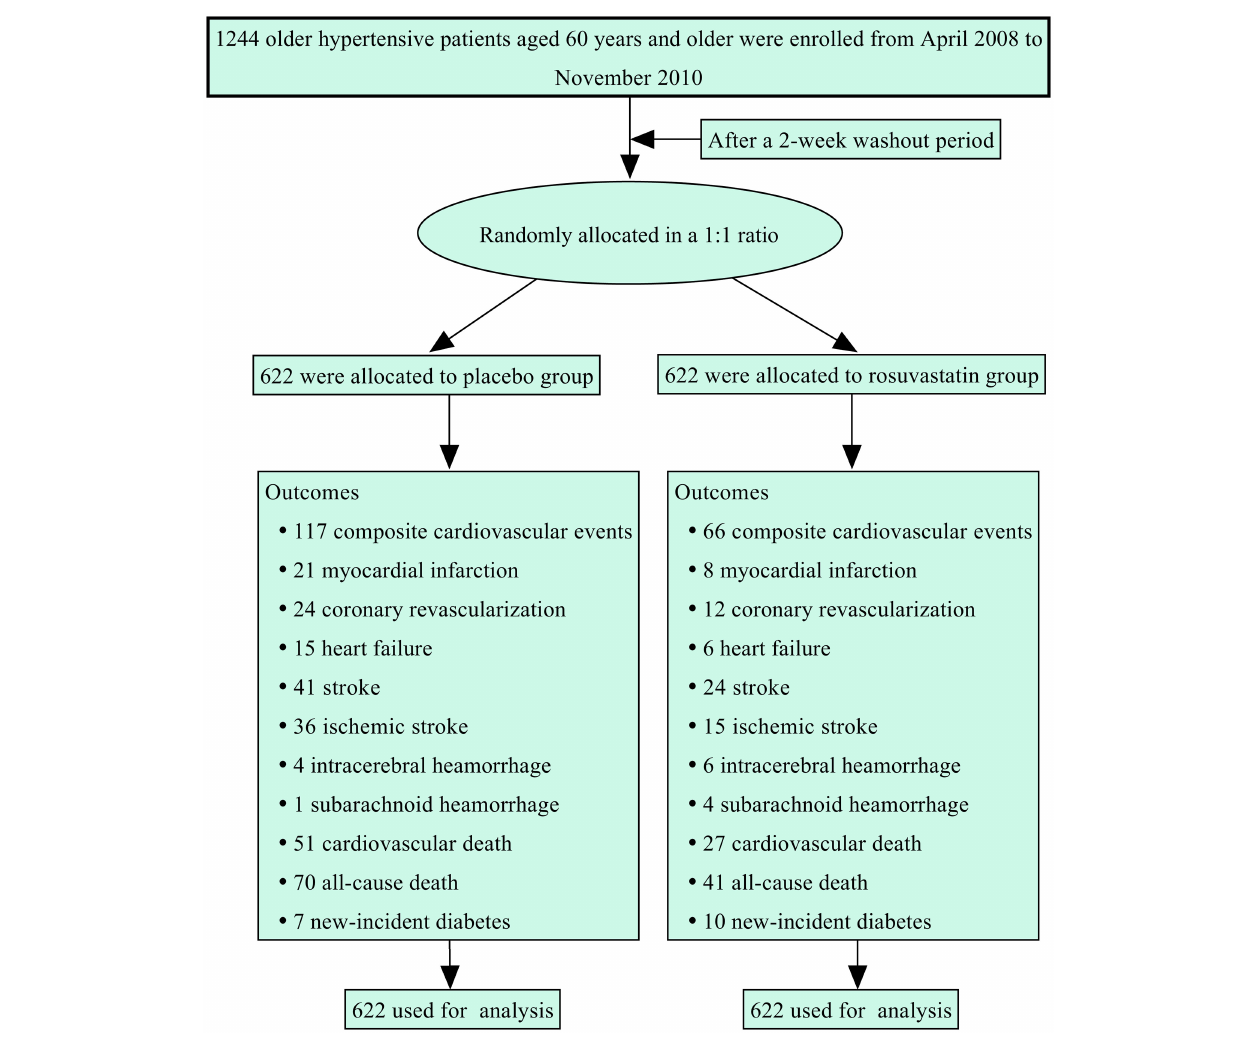
FIGURE 1 | The protocol